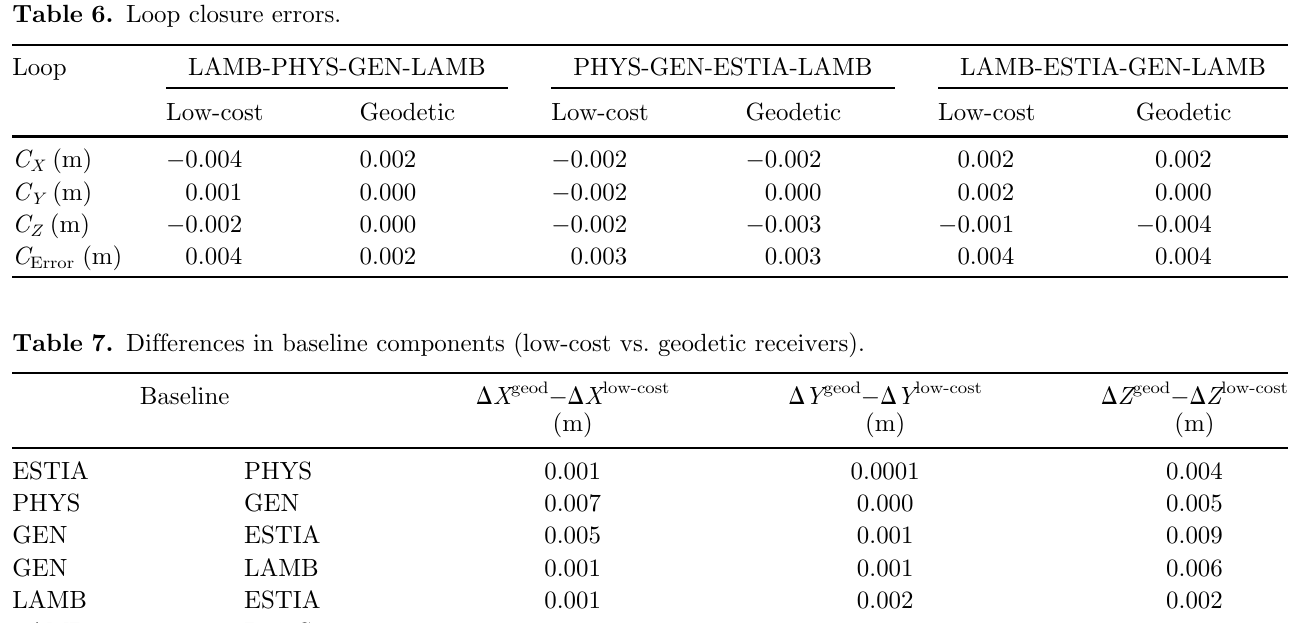
Mean ± stand. deviation